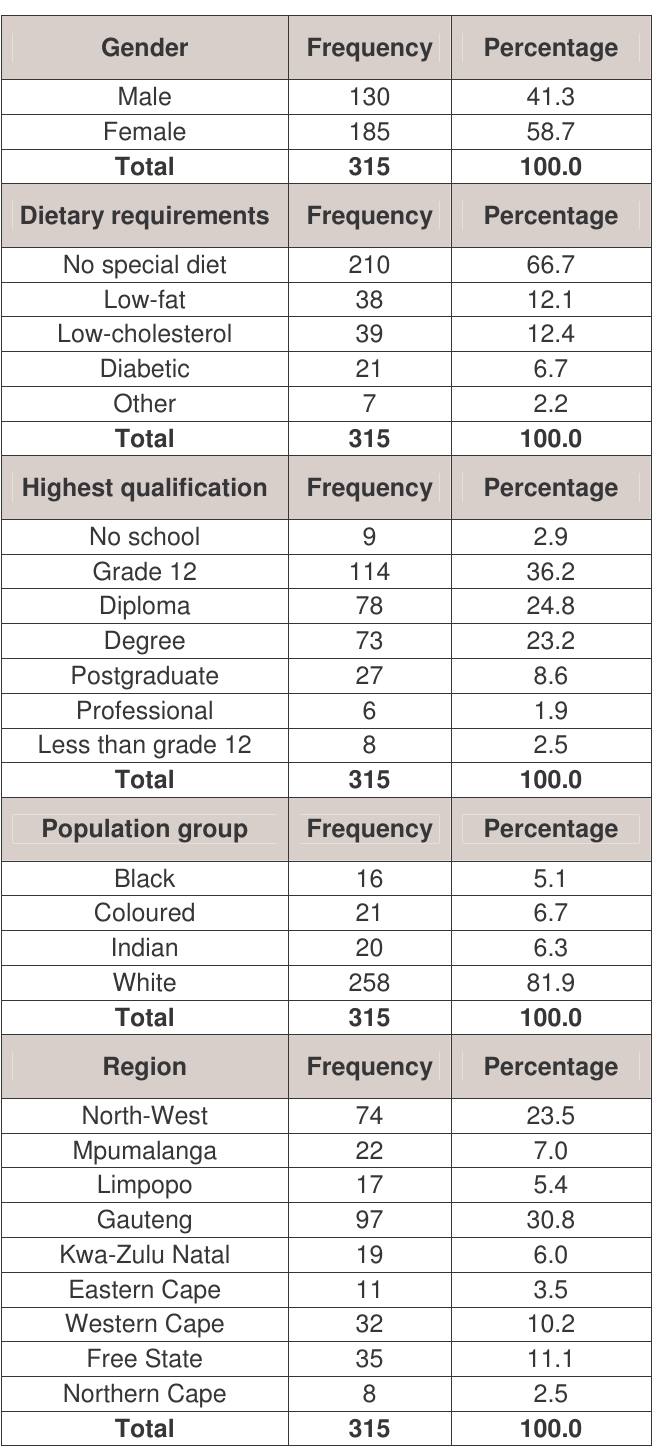
Table 2: Demographic characteristics of